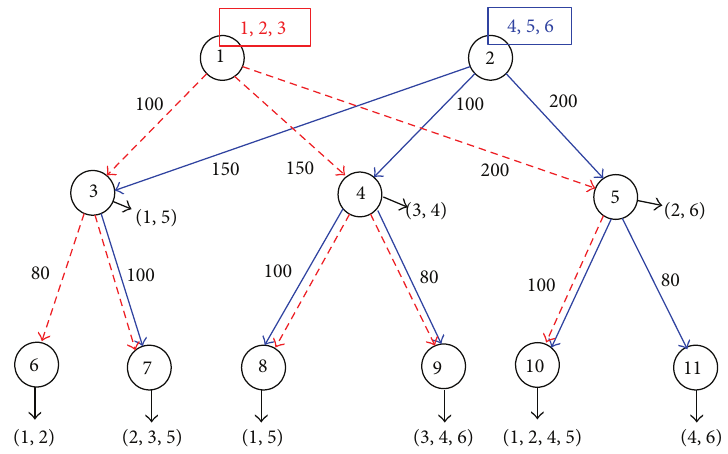
Figure 7: Content distribution from two